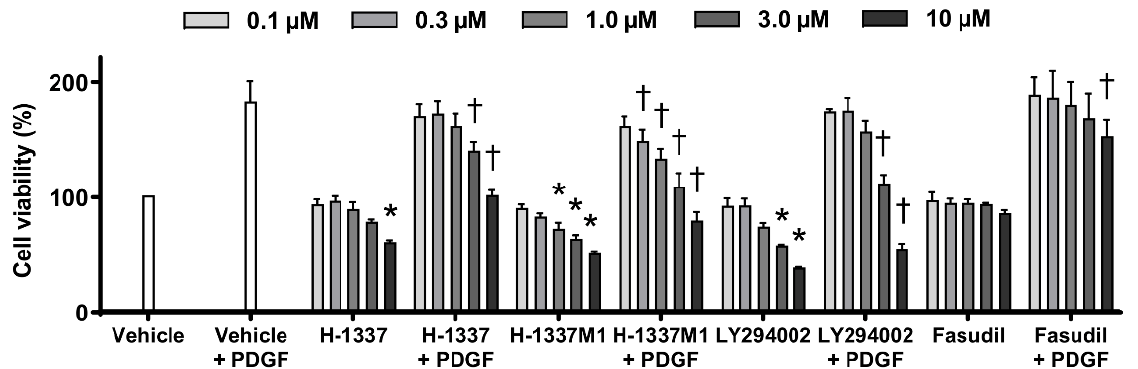
Figure 4. Antiproliferative effects in human pulmonary artery smooth muscle cells (hPASMCs). The viability of hPASMCs treated with H-1337, H-1337M1, and LY294002 was assessed using Cell Counting Kit-8 assays. hPASMCs were incubated with platelet-derived growth factor (PDGF; 10 ng/mL) and treated with different concentrations (0.1–10 µM) of H-1337, H-1337M1, LY294002 (phosphatidylinositol 3-kinase inhibitor), or fasudil (ROCK inhibitor). *: analyzed by ANOVA, p < 0.05 versus vehicle; †: p < 0.05 versus vehicle + PDGF.